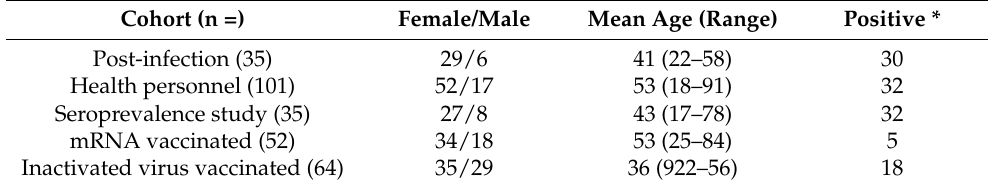
Table 1. Characteristics of the sample cohorts.